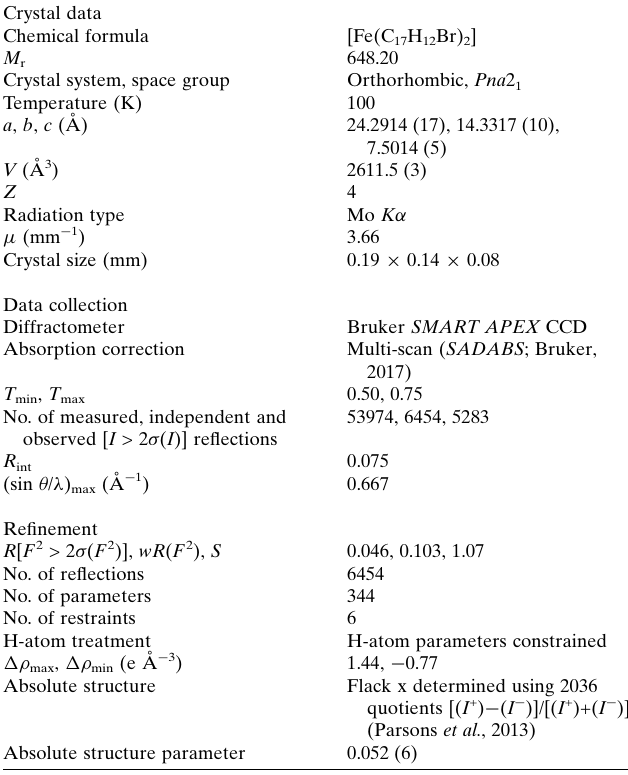
Table 1 Experimental details. Crystal data Chemical formula